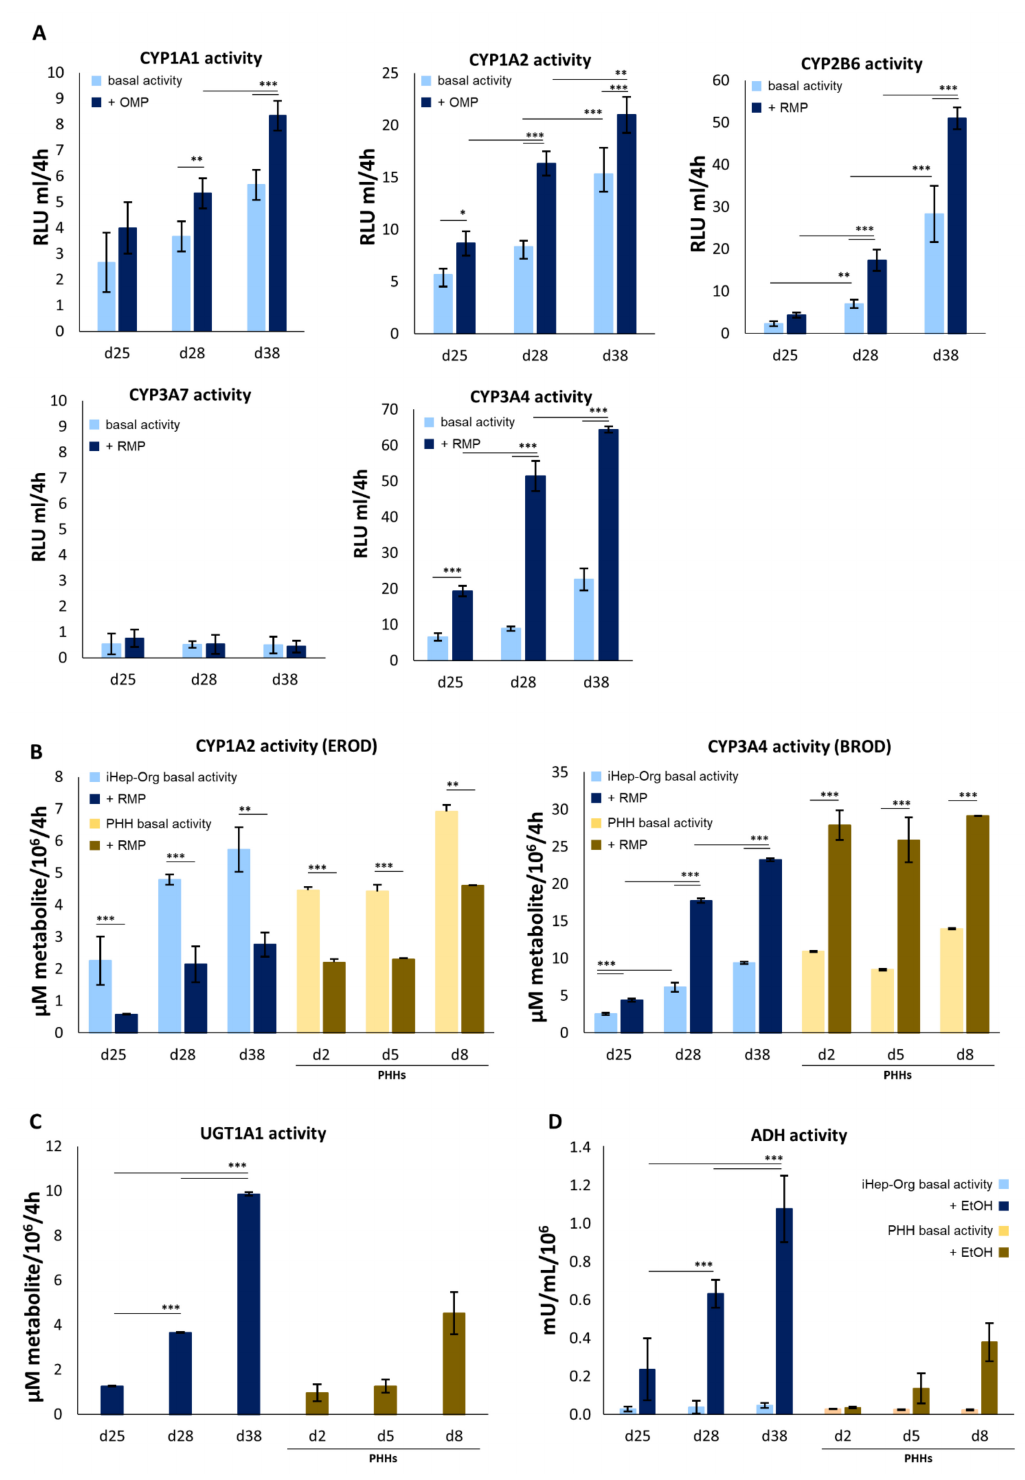
Figure 4. Activity of phase I and II metabolisms of iHep-Orgs. ( A ) CYP1A1, CYP1A2, CYP2B6, CYP3A7 and CYP3A4 activities measured in iHep-Orgs without (light bars) and after induction (blue bars). Histograms represent mean ± SD ( n = 3). ( B ) CYP1A2 (EROD) and CYP3A4 (BROD) specific activities of iHep-Orgs (blue shade bars) and PHH-Orgs (brown shade bars). Histograms represent mean ± SD ( n = 8). ( C ) UGT1A1 activity of iHep-Orgs (blue bars) and PHH-Orgs (brown bars). Graph represents mean ± SD ( n = 6). ( D ) ADH activity of iHep-Orgs (blue shade bars) and PHH-Orgs (brown shade bars). *** indicates p < 0.001; ** indicates p < 0.01; * indicates p <